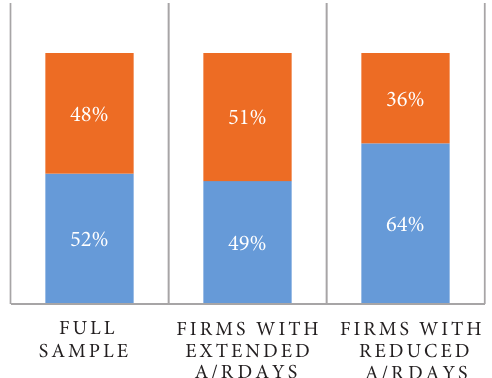
Figure 2. Short-term borrowings and Profitability under the influence of A/R